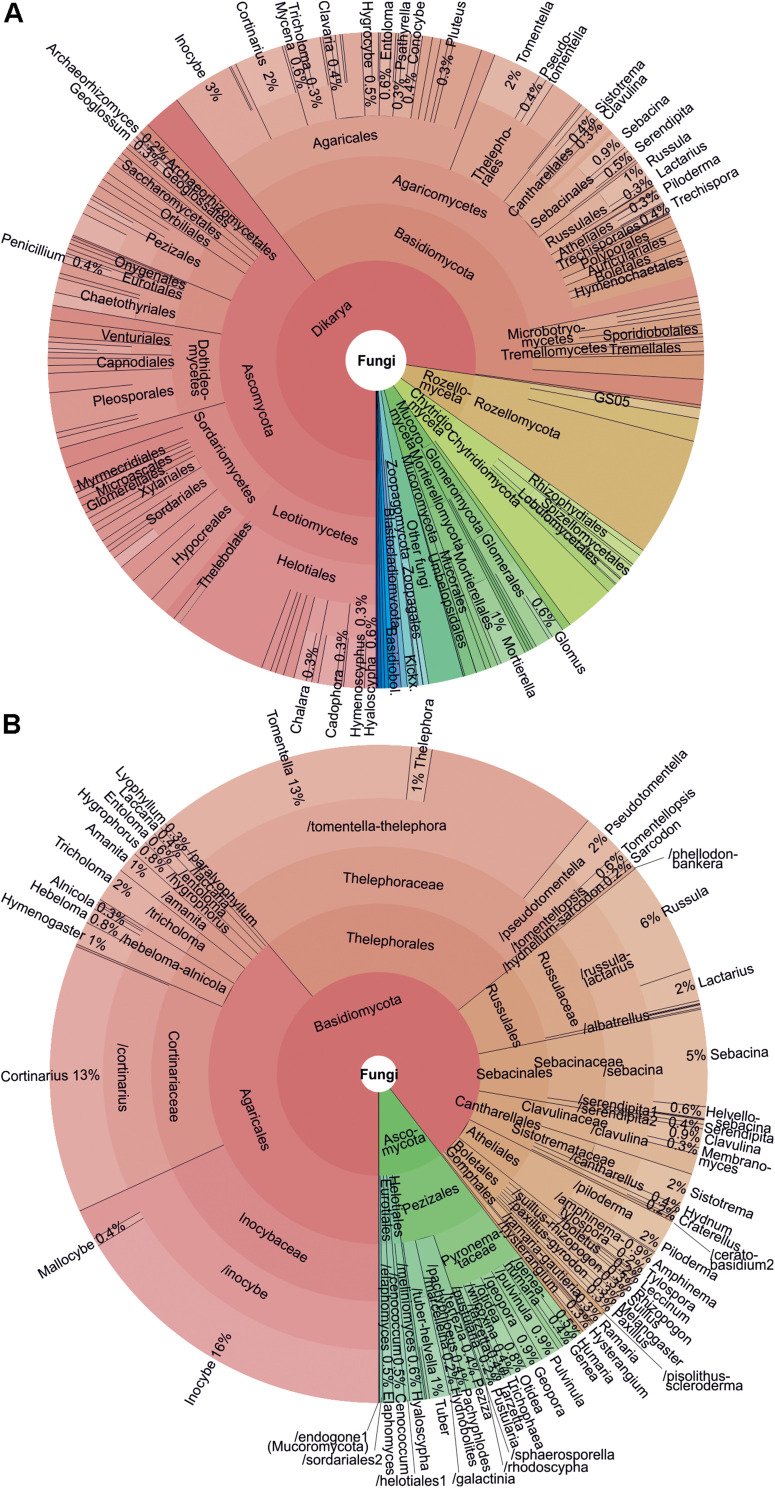
Krona charts showing (A) taxonomic distribution of all fungi and (B) ectomycorrhizal fungi as based on OTU richness.